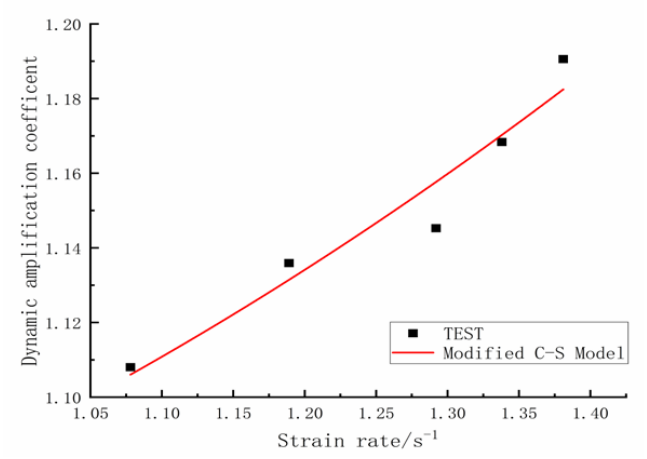
Figure 6. Cowper–Symonds model fitting curve of DIFy.